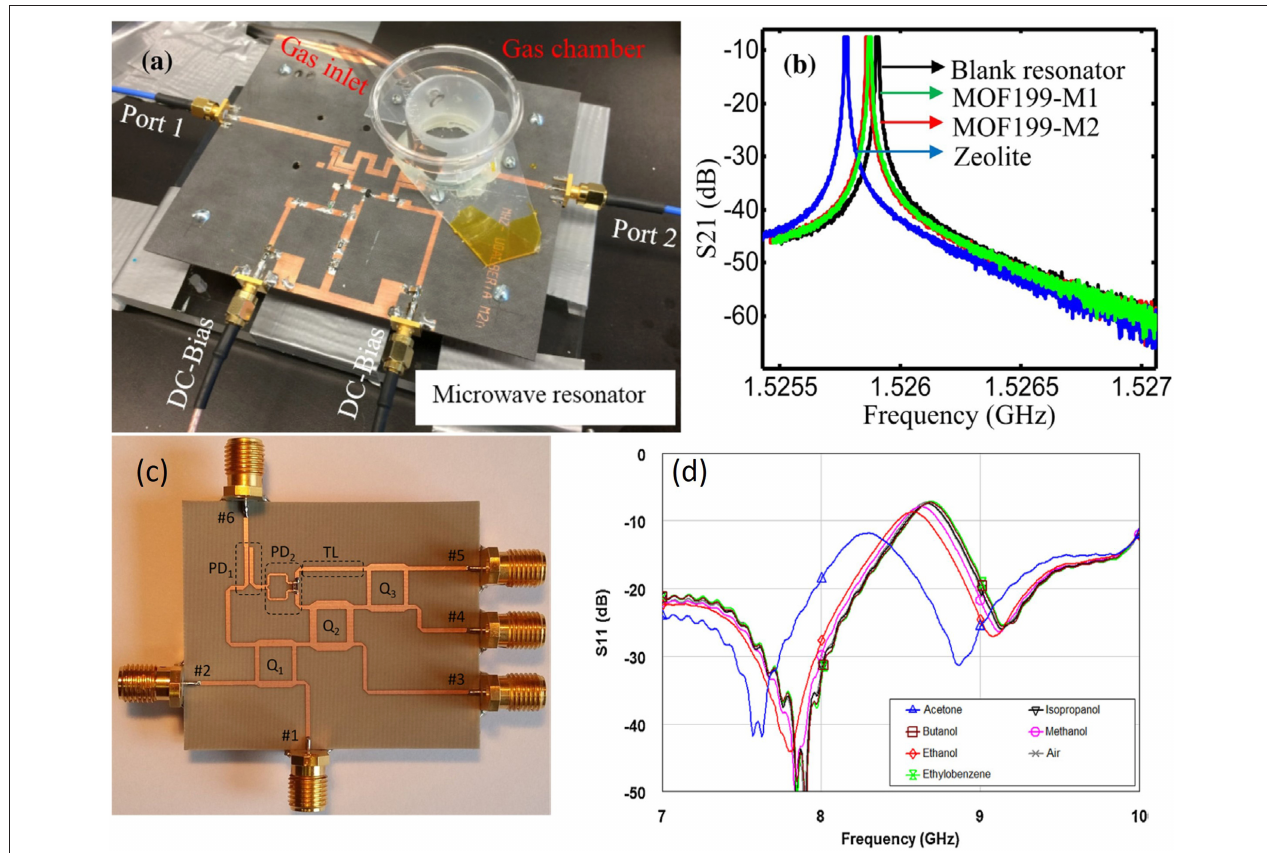
FIGURE 9 | (a) Experimental setup with the microwave active resonator sensor, (b) resonant profile (S21) of the sensor based on the active resonator, (c) photograph of the fabricated six-port reflectometer, (d) resonant profile S11 of the sensor based on the six-port reflectometer. Reproduced with permissions from Staszek et al.